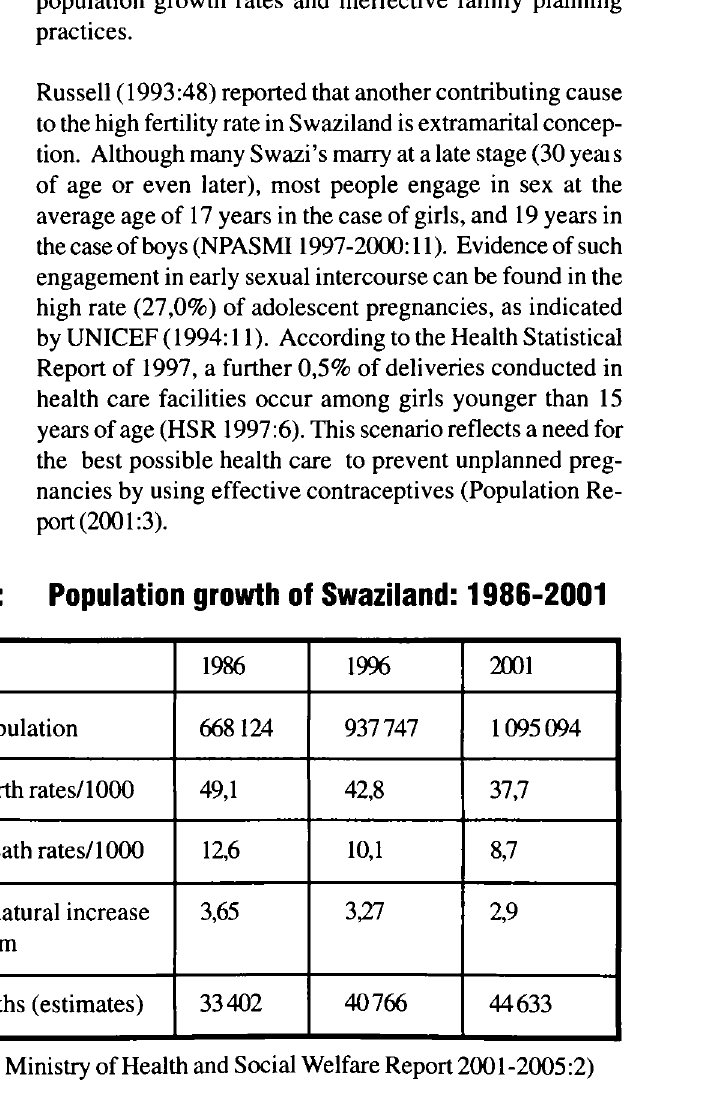
Population growth of Swaziland: